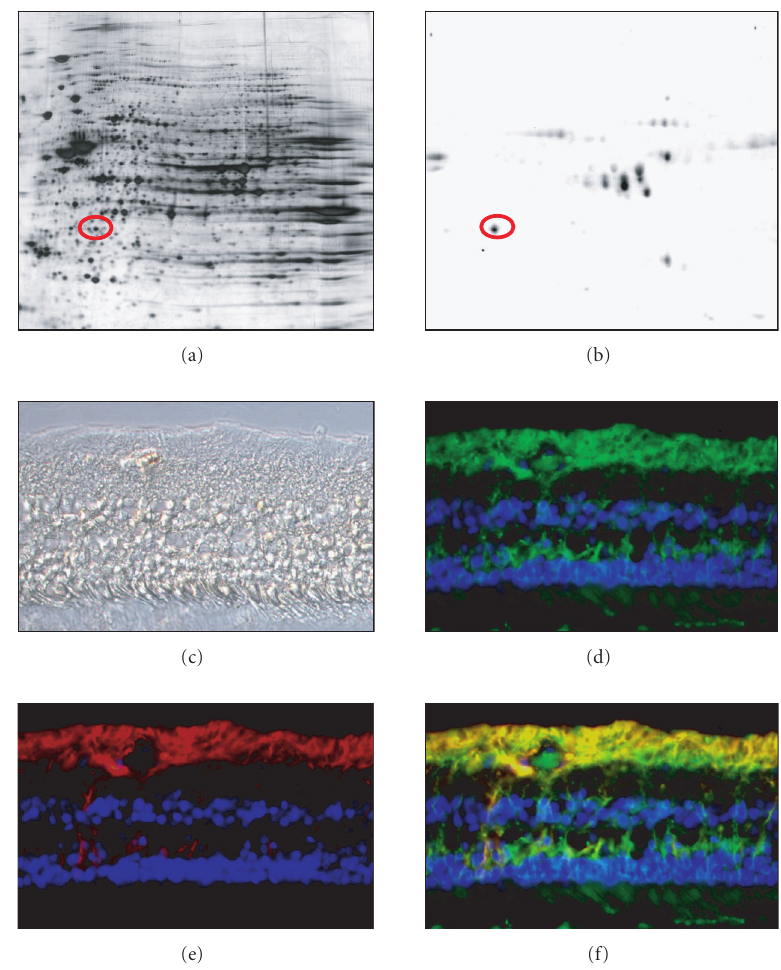
Figure 1: Identification of CRALBP-autoantibodies with proteomic Western blots. (a) Equine retinal proteome (pH gradient 3–11, silver stain- ing) was separated on 2D gels and transferred to nitrocellulose membranes. (b) Serum from human uveitis patient detects CRALBP (en- circled). CRALBP expression in normal human eyes. (c) Nomarski image of normal human retina (donor no. 6, male, age 49). (d) CRALBP expression (green) at Mueller glial cells. (e) GFAP expression (red) at Mueller glial cells. (f) Double labeling of CRALBP (green) and GFAP (red) clearly demonstrates colocalization (yellow) of CRALBP and GFAP at Mueller glial